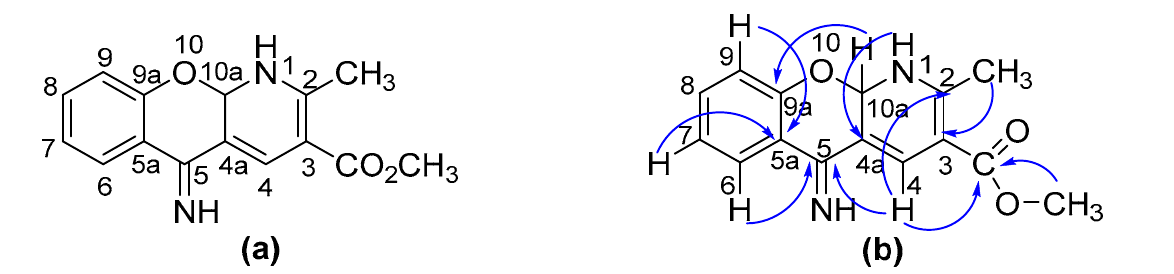
Figure 1. (a) Structure and numbering of the title compound 6 and (b) main correlations observed Figure 1. ( a ) Structure and numbering of the title compound 6 and ( b ) main correlations observed in the HMBC in the HMBC spectrum.